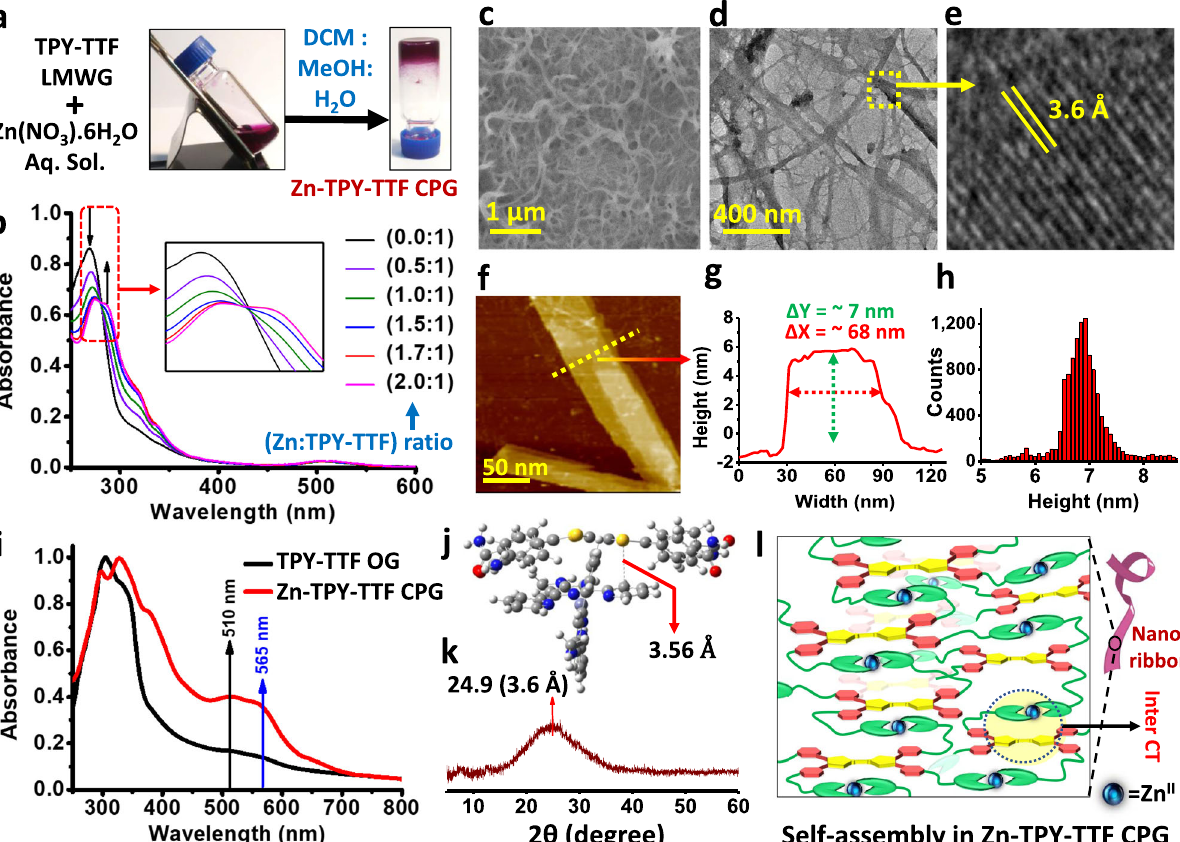
Fig. 3 Preparation and characterizations of Zn-TPY-TTF CPG. a Photograph for Zn-TPY-TTF CPG formation. b UV-visible titration of TPY-TTF LMWG with Zn II ion. c FE-SEM image of Zn-TPY-TTF CPG xerogel. d HR-TEM image of Zn-TPY-TTF CPG xerogel. e Lattice fringes of the selected region. f AFM image of Zn-TPY-TTF CPG xerogel and corresponding, g height pro fi le and h height histogram. i Comparison of absorption spectra of TPY-TTF OG and Zn-TPY-TTF CPG. j Interplanar spacing in the optimized structure of TTF---[Zn(TPY) 2 ] 2 + stacked model obtained through DFT calculation. k PXRD of Zn-TPY-TTF CPG xerogel. l Schematic representation for self-assembly of Zn-TPY-TTF